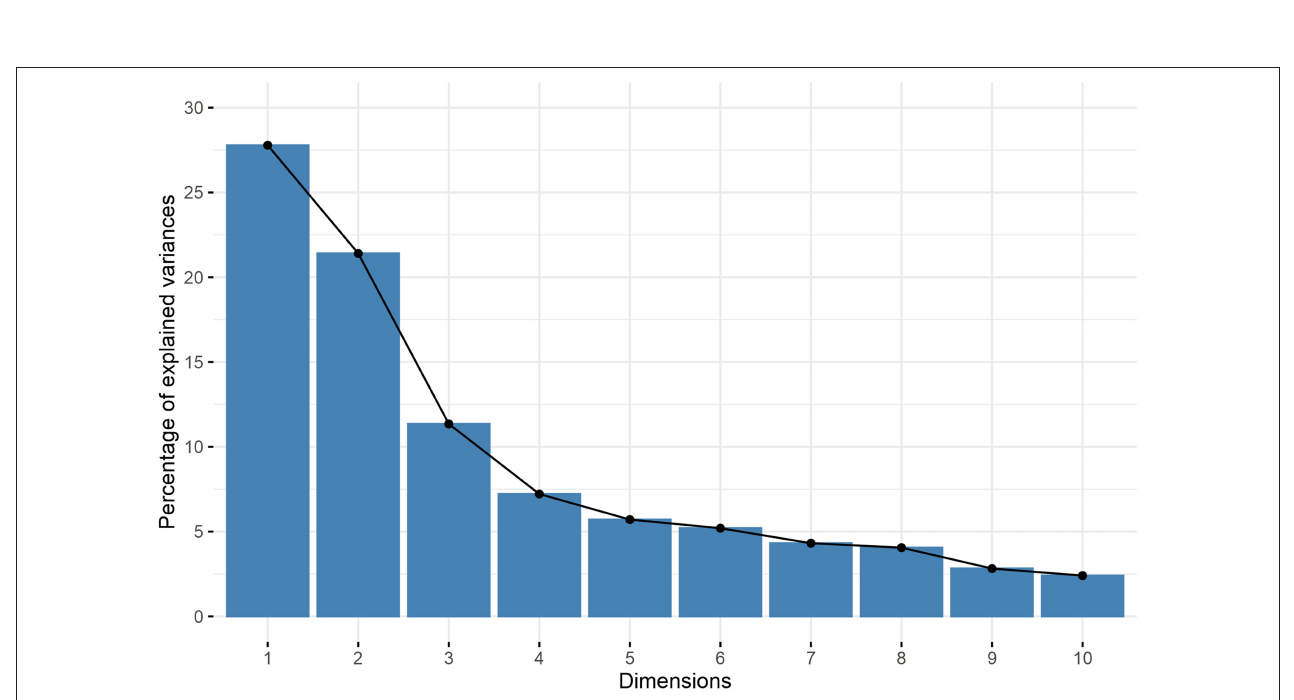
FIGURE 5 | Scree plot showing eigen values of dimensions of PCA, in association with Figure 4 .